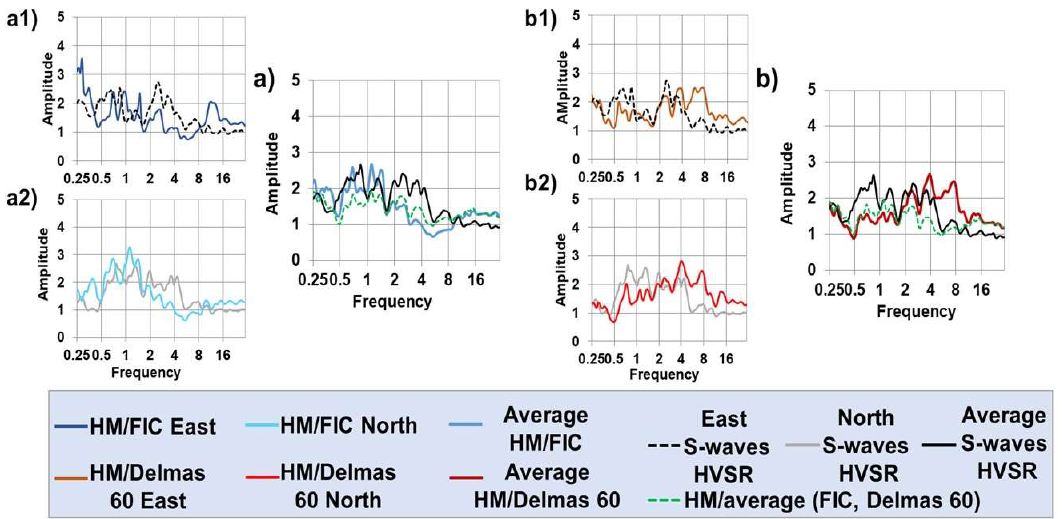
Figure 2. Comparison between the standard spectral ratio (SSR) and S-wave HVSR results for station Hotel Montana (HM). ( a ) SSR computed with respect to FIC station, in ( a1 ) for the E–W component, in ( a2 ) for the N–S component; ( b ) SSR computed using the Delmas 60 station as reference, in ( b1 ) for the E–W component, in ( b2 ) for the N–S component. In both subfigures ( a , b ), the black curve represents the S-wave HVSR for HM station, and the green dashed curve shows the average SSR for HM computed with respect to the averaged FIC-Delmas 60 spectra (combination of two reference stations); see also dashed curve of E–W S-waves HVSR in ( a1 , b1 ) and grey curve of N–S S-waves HVSR in ( a2 , b2 ).